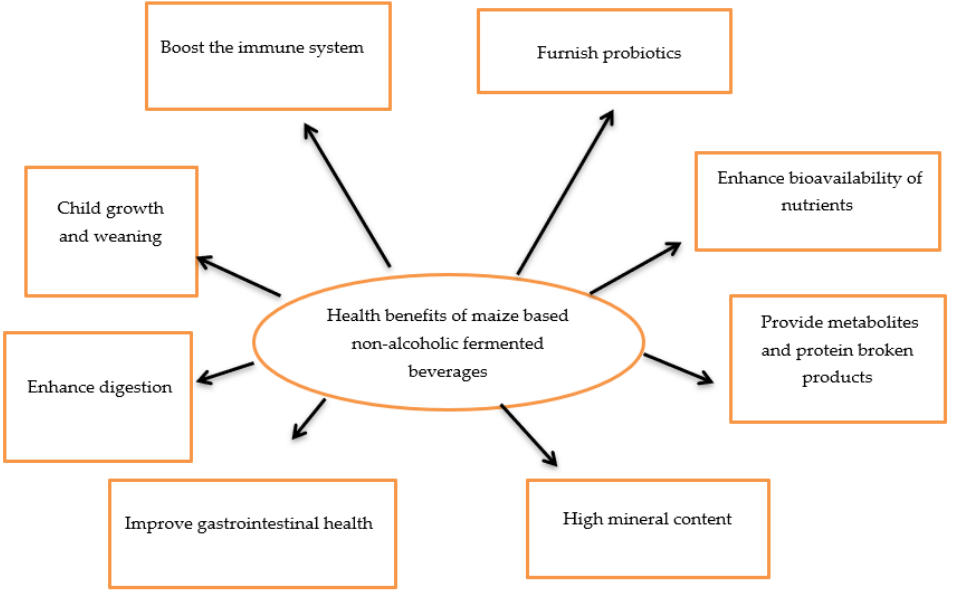
Figure 2. Health benefits of maize-based non-alcoholic fermented beverages.